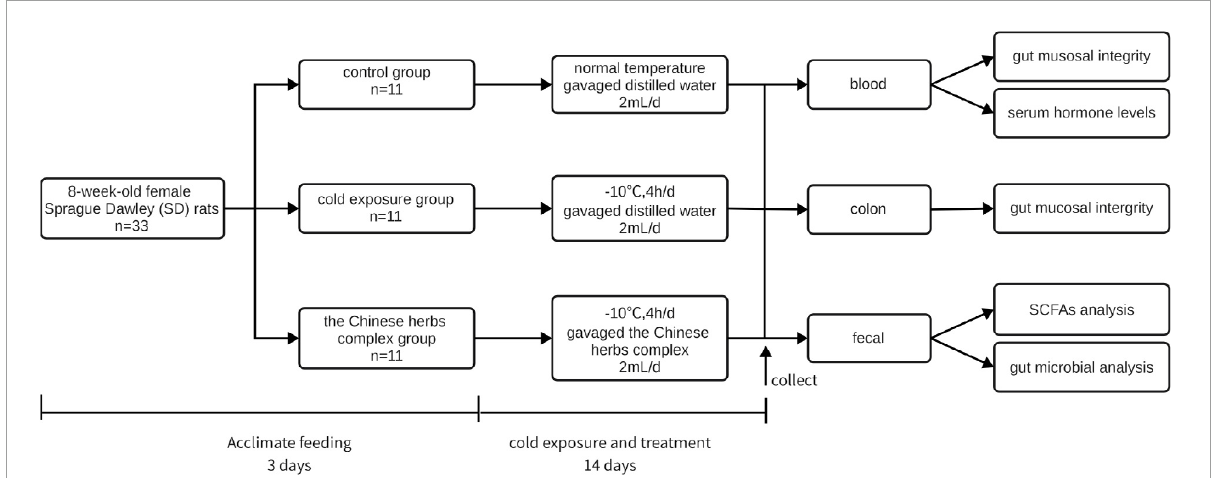
FIGURE1 Chart of the experimental protocol. Thirty-three 8-week-old female Sprague Dawley (SD) rats (body weight 185.82 ± 5.89 g) were housed at a temperature of 23 ◦ C ± 1 ◦ C and relative humidity of 40% to 60% with a 12-h light/dark cycle. The animals had free access to tap water and diet for 5 days before being randomly assigned to the control group (C), cold exposure group (CE), and Chinese herbs complex group (CH) based on body weight. The rats in the C and CE groups were intragastrically administrated distilled water, and the rats in the CH group were given Chinese herbs complex by gavage once a day. After the treatment, the cold exposure group and Chinese herbs complex group were exposed to − 10 ◦ C in a cabin for 4 h every day, and the treatment time lasted for 14